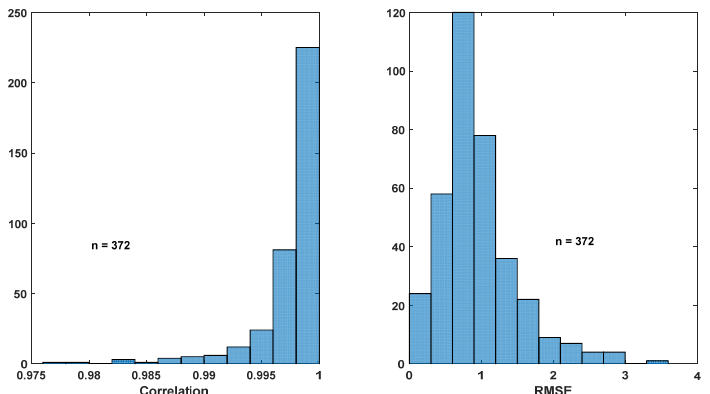
Figure 7. Histograms of correlation and RMSE between original and reconstructed thigh angle waveforms using five harmonics.